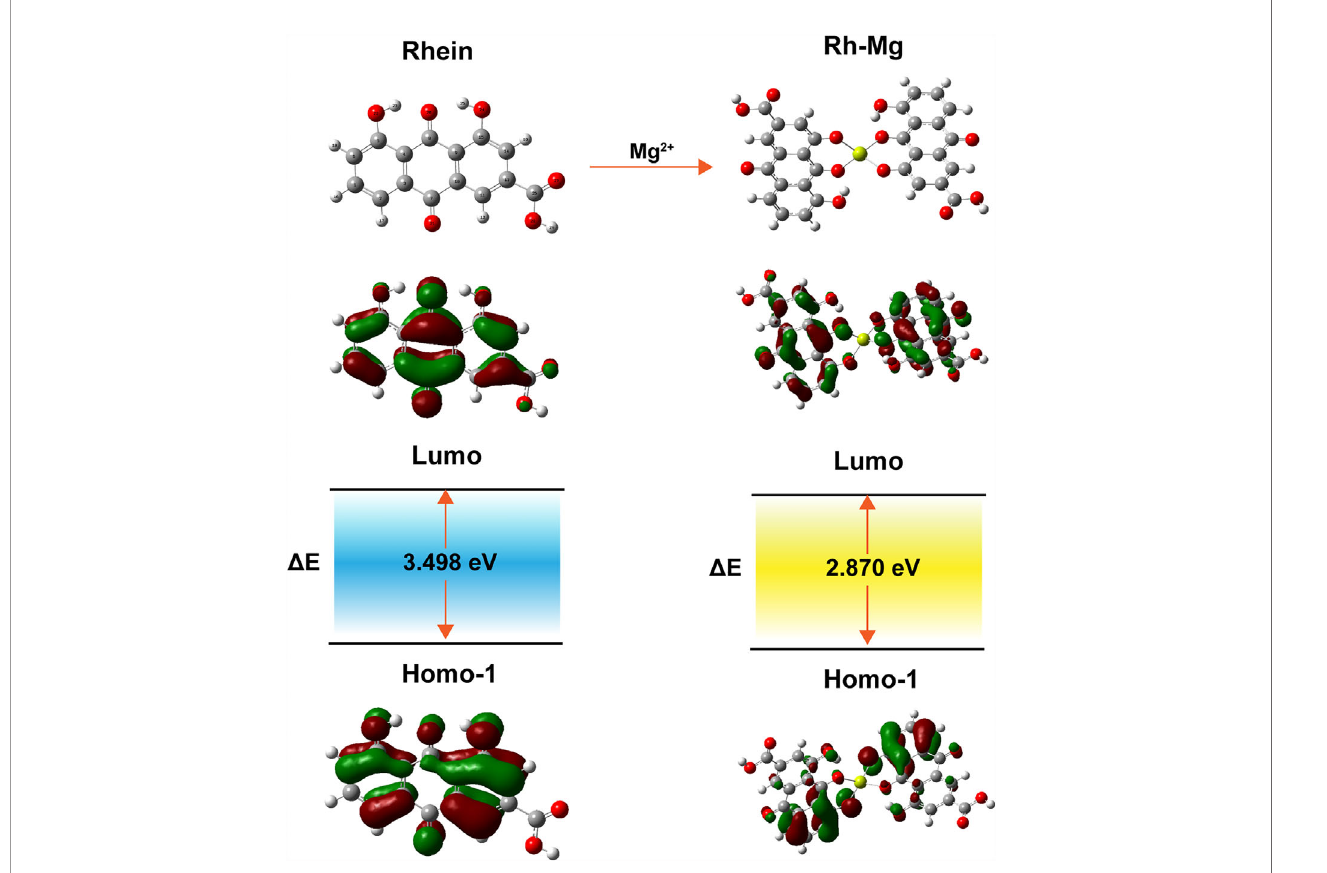
FIGURE 3 | HOMO and LUMO orbitals of rhein and